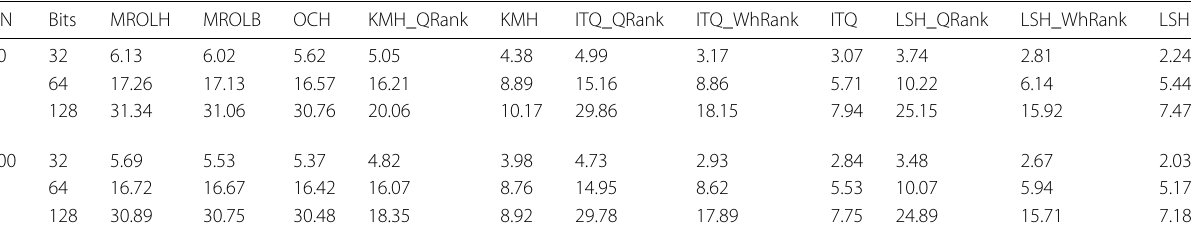
Table 3 The mAP ( % ) values of the comparative experimental results in the SIFT1M dataset NN